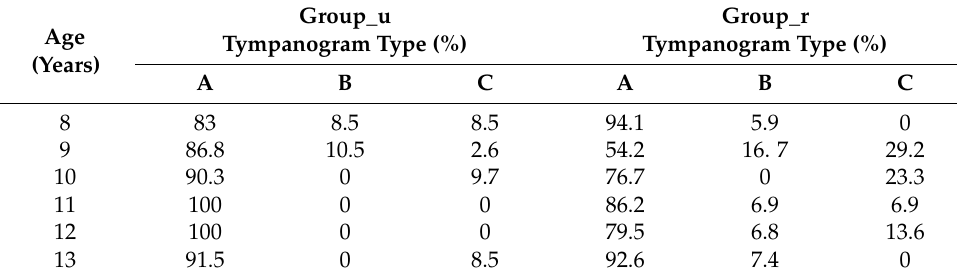
Table 2. Percentage of type of tympanogram (A, B, or C) by age and place of